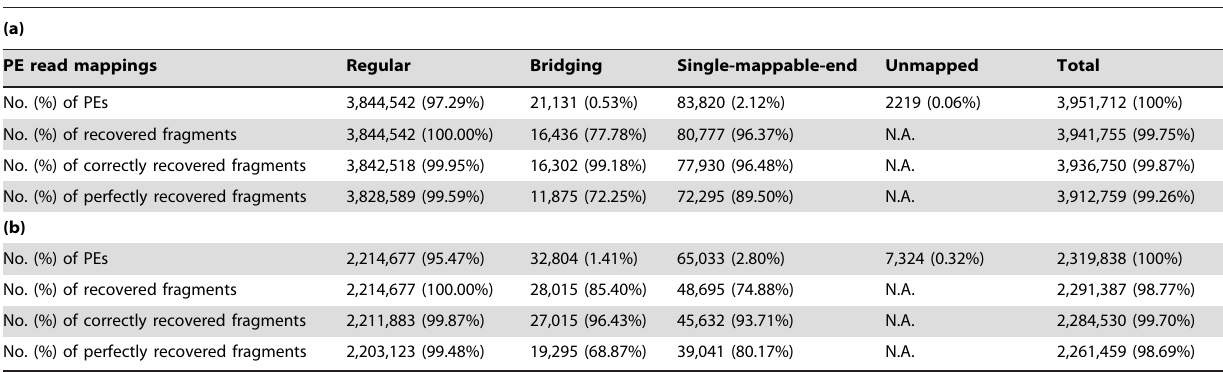
Table 4. Statistics of DNA fragments recovered from the simulated PEs of